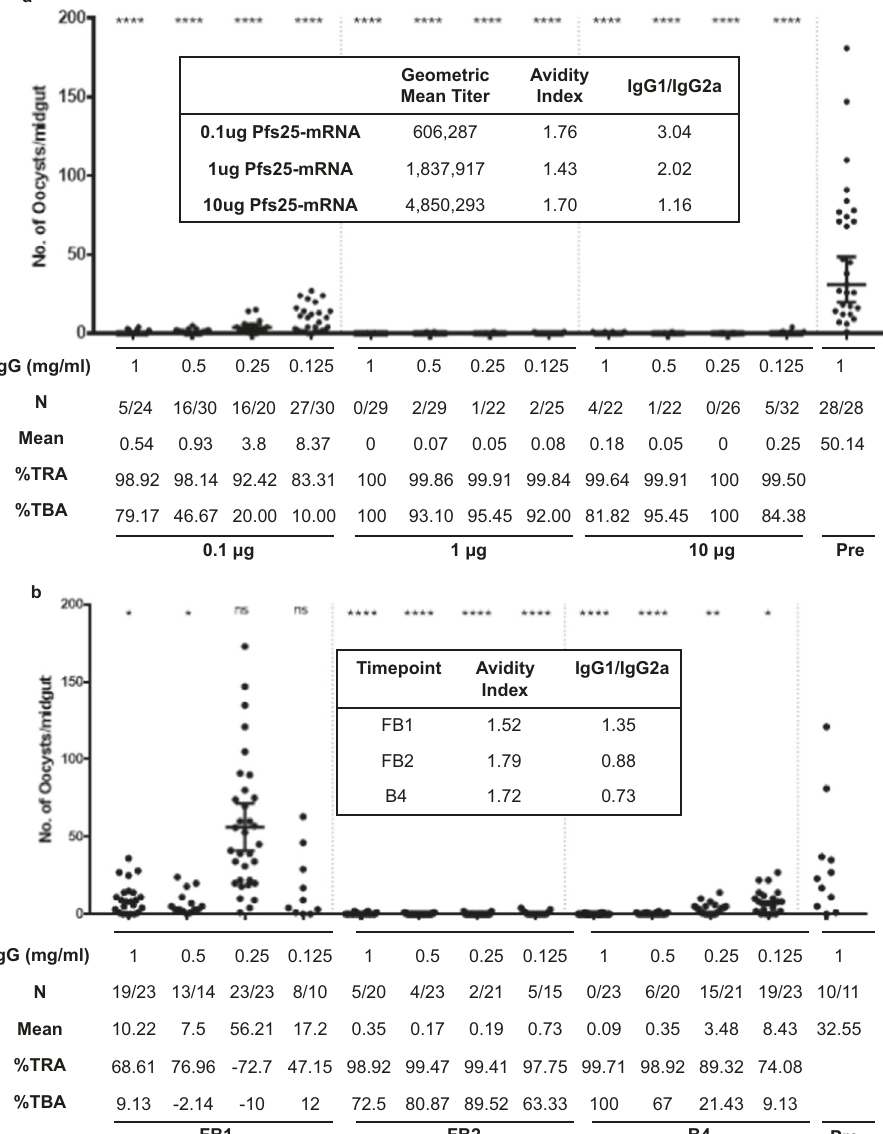
Fig. 7 Transmission reducing activity of antibodies elicited by lower doses and varying immunization schedules of Pfs25 mRNA-LNP. a Puri fi ed IgG from pooled sera (bleed B3) from Balb/c mice immunized with 0.1 μ g, 1 μ g, and 10 μ g Pfs25 mRNA-LNPs (Fig. 6c) were evaluated at indicated fi nal concentrations by SMFA. The inset shows the geometric mean antibody titers, avidity indices, and IgG1/IgG2a ratios for the serum evaluated by SMFA. b SMFA data for puri fi ed IgG in FB1, FB2, and B4 (Fig. 6a – c) from Balb/c mice immunized with one, two and three doses of 10 μ g of Pfs25 mRNA-LNP, respectively. The inset shows the antibody avidity indices and IgG1/IgG2a ratios for the serum evaluated by SMFA. Data points representing the oocyst counts from each mosquito, arithmetic means, and 95% con fi dence intervals are reported. N is the fraction of uninfected mosquitoes over the total number of mosquitoes dissected. %TRA is the mean reduction in oocysts in the presence of the test IgG compared with the IgG (1 mg/ml) from pre-immune mouse sera (Pre) used as a negative control. %TBA is the percent reduction in the proportion of infected mosquitoes in the presence of the test IgG compared with pre-immune mouse IgG negative control (Pre). Statistical analysis was performed using the Mann – Whitney U test (* p < 0.05; ** p < 0.01; *** p < 0.001; **** p <